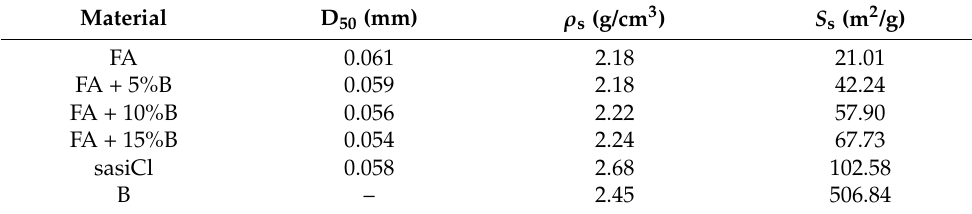
Figure 1. Grain-size distribution curves of all tested materials. The physical parameters for the averaged research samples: median grain diameter ( D 50 ), density of solid particles ( ρ s ) and specific surface ( S s ) measured by the methylene blue spot test, are shown in Table 2. Table 2. The parameters of tested